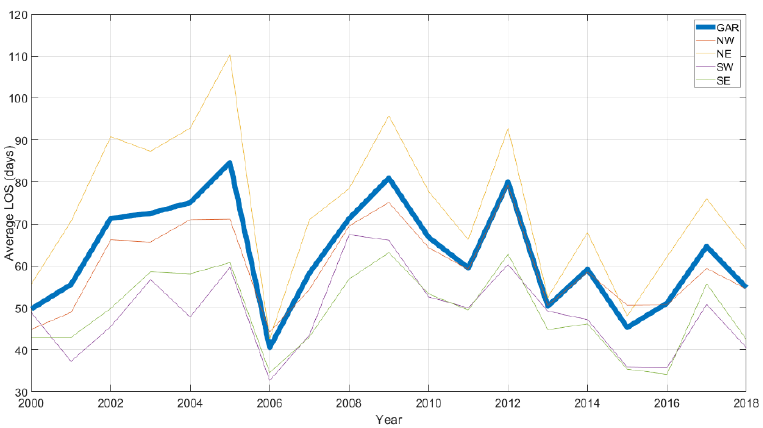
Figure 5. ( a ) Standard deviations of the snow cover season length (LOS) in the 2000–2019 period expressed in days; ( b ) ratio between the LOS standard deviations and LOS mean values; ( c ) quantiles of the distribution of the ratios between the LOS standard deviations and LOS mean values in each 5-m interval of the GAR elevation range.